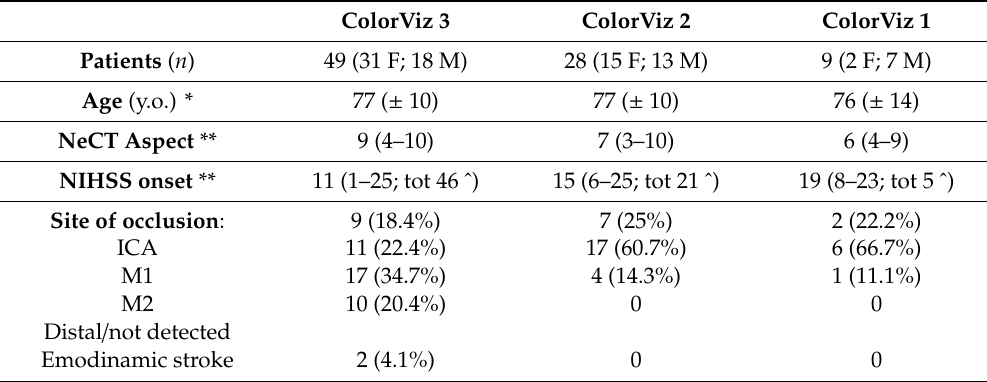
Table 2. Patients characteristics.